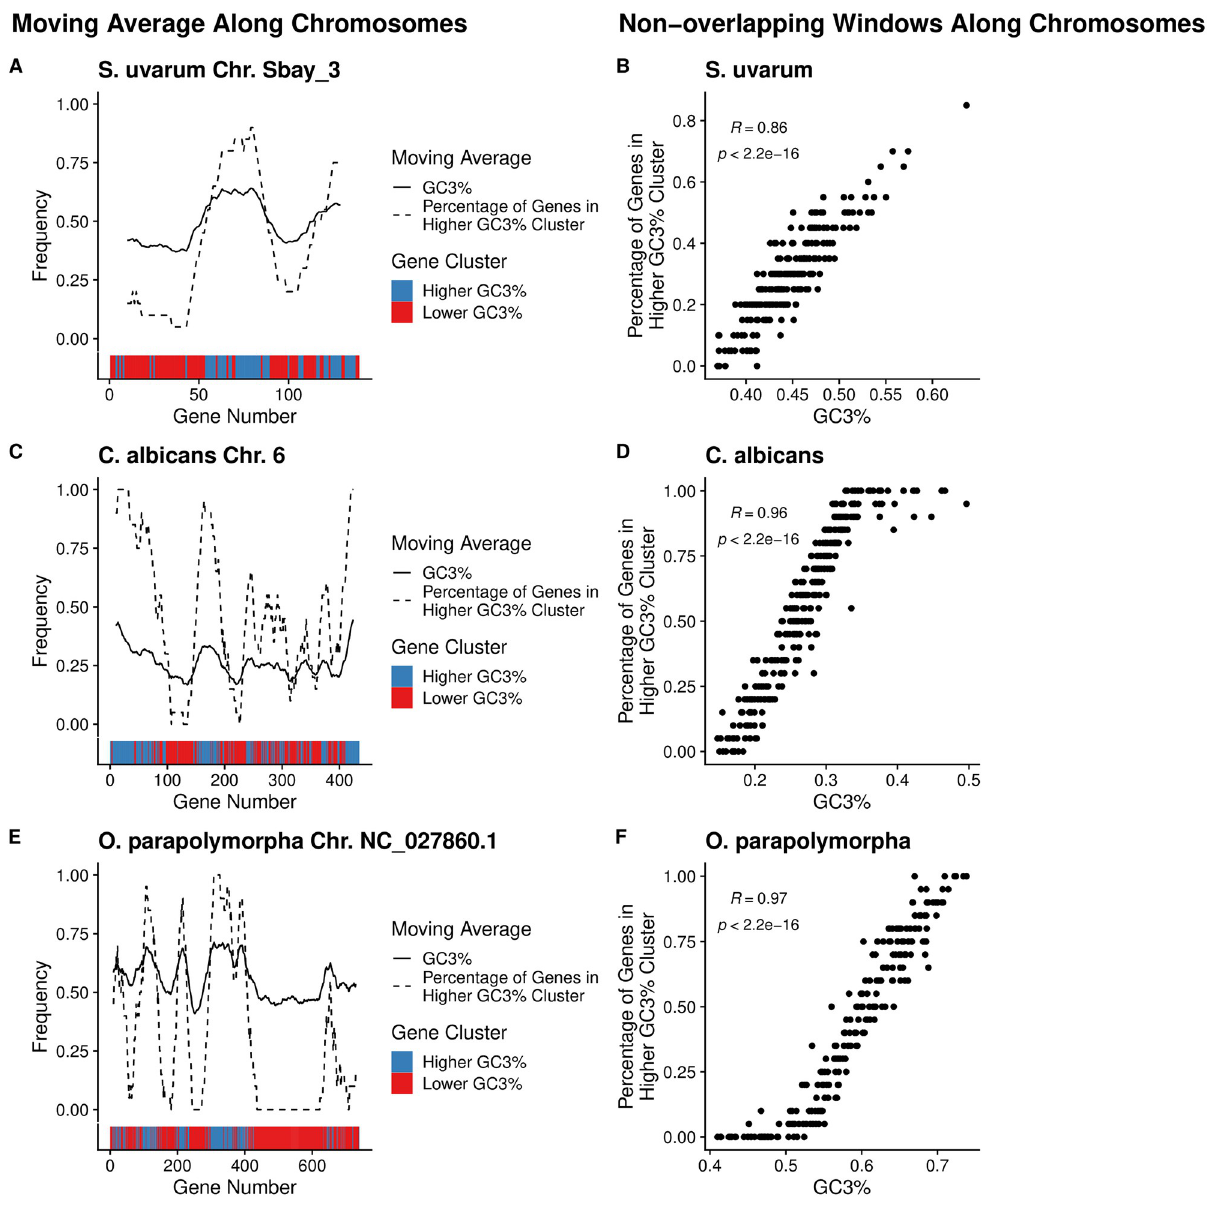
Fig 3. Genes evolving under similar non-adaptive nucleotide biases are cluster along chromosomes. (Left panel) Per-gene GC3% content across select chromosomes quantified as a moving average using a 20 gene sliding window (solid line). For each 20 gene window, the percentage of genes assigned to the Higher GC3% regime is also shown (dashed line). Color bars indicate the mutation regimes for Higher and Lower GC3% (blue and right, respectively). (Right panel) Scatter plots showing per-gene GC3% and percentage of genes assigned to the Higher GC3% regime using non- overlapping 20 gene windows across all chromosomes. The independence of windows allows us to apply the Spearman Rank correlation. (A,B) S. uvarum . (C,D) C. albicans . (E,F) O. parapolymorpha